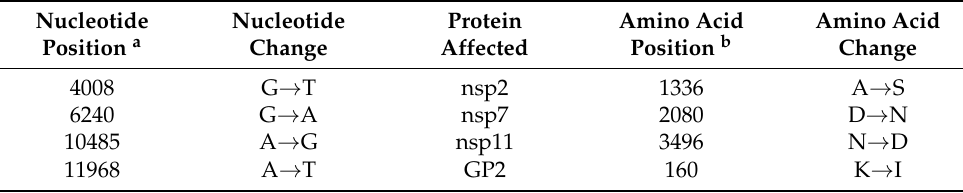
Table 4. Mutations only found in the C1 virus but not in the P95 and C2 viruses.